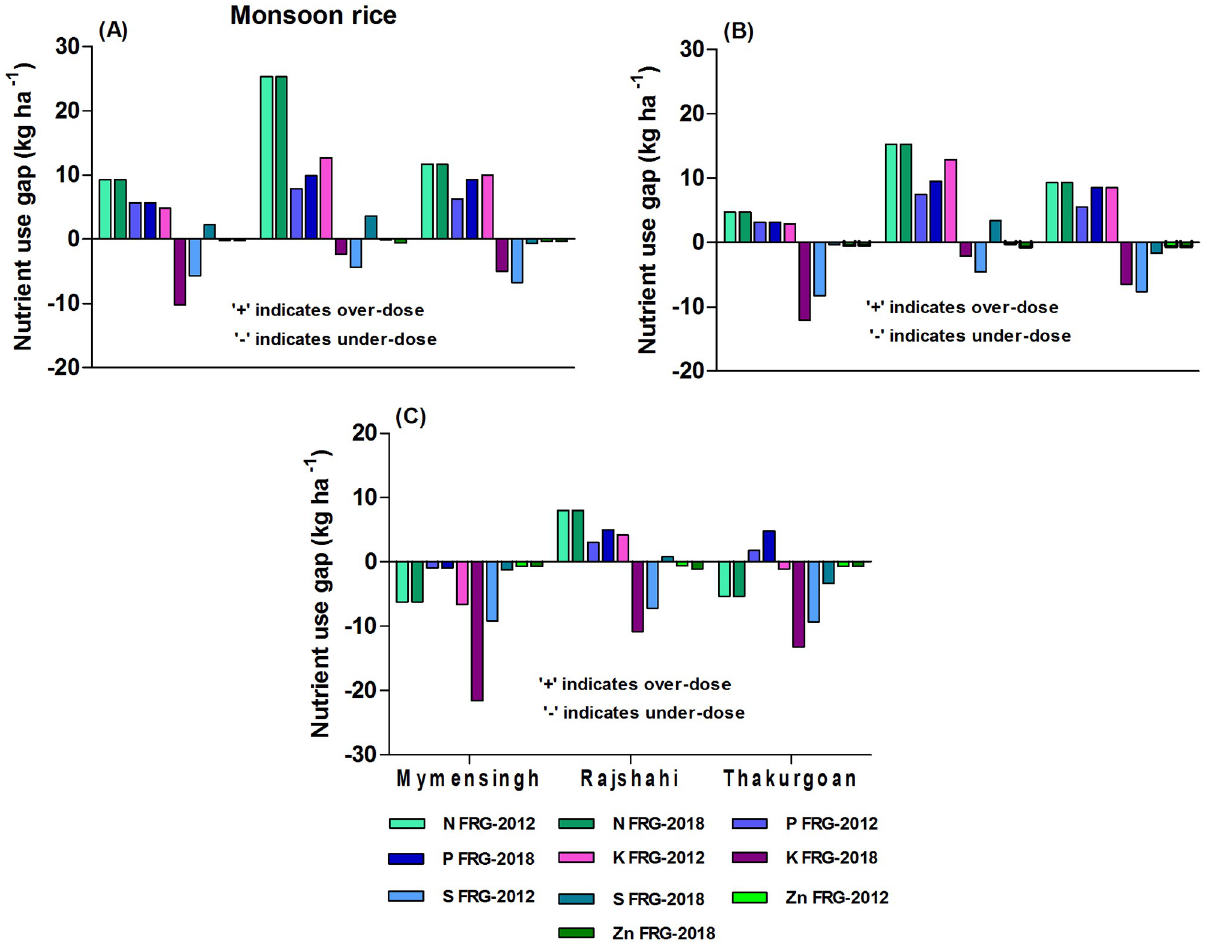
Fig 2. Farms’ current nutrient use gaps relative to FRG-2012 and FRG-2018 for monsoon rice: A) large-scale farms B) medium-scale farms C) small-scale farms for the irrigated rice-fallow-monsoon rice cropping pattern.